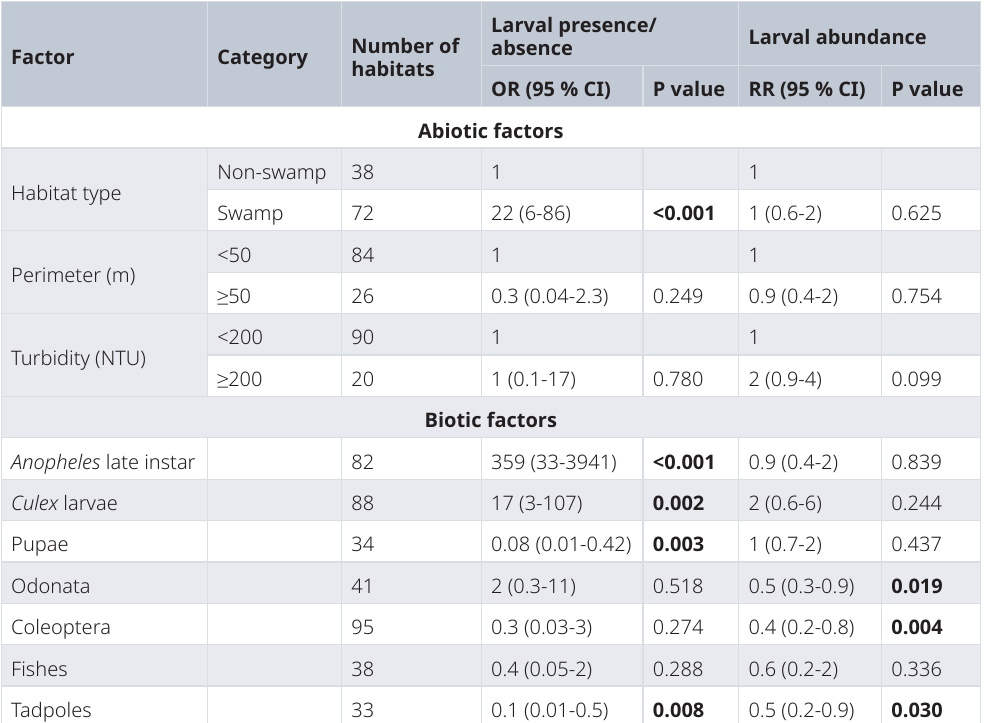
Table 5. Output of multivariate analysis of the presence or abundance of early instar Anopheles larvae as outcome, and biotic and abiotic factors as explanatory